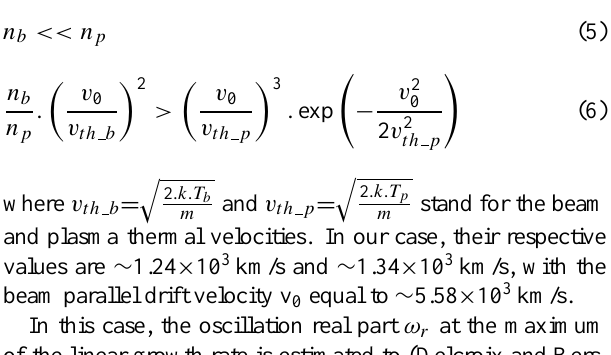
AG/2006337 Figure 9 .ps